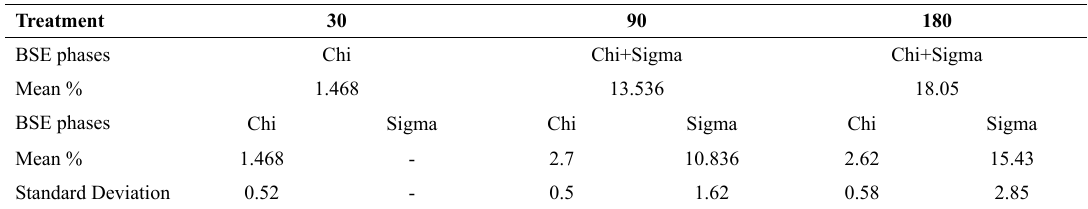
Table 2. Amount of chi and sigma phases measured by image analysis for the ageing at 830 ºC for different times. Treatment